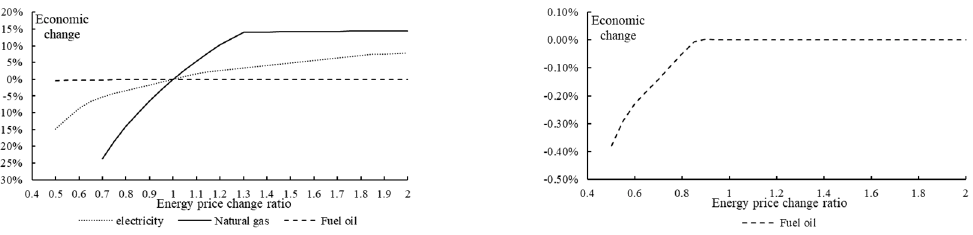
Figure 18. System economic sensitivity to energy prices.